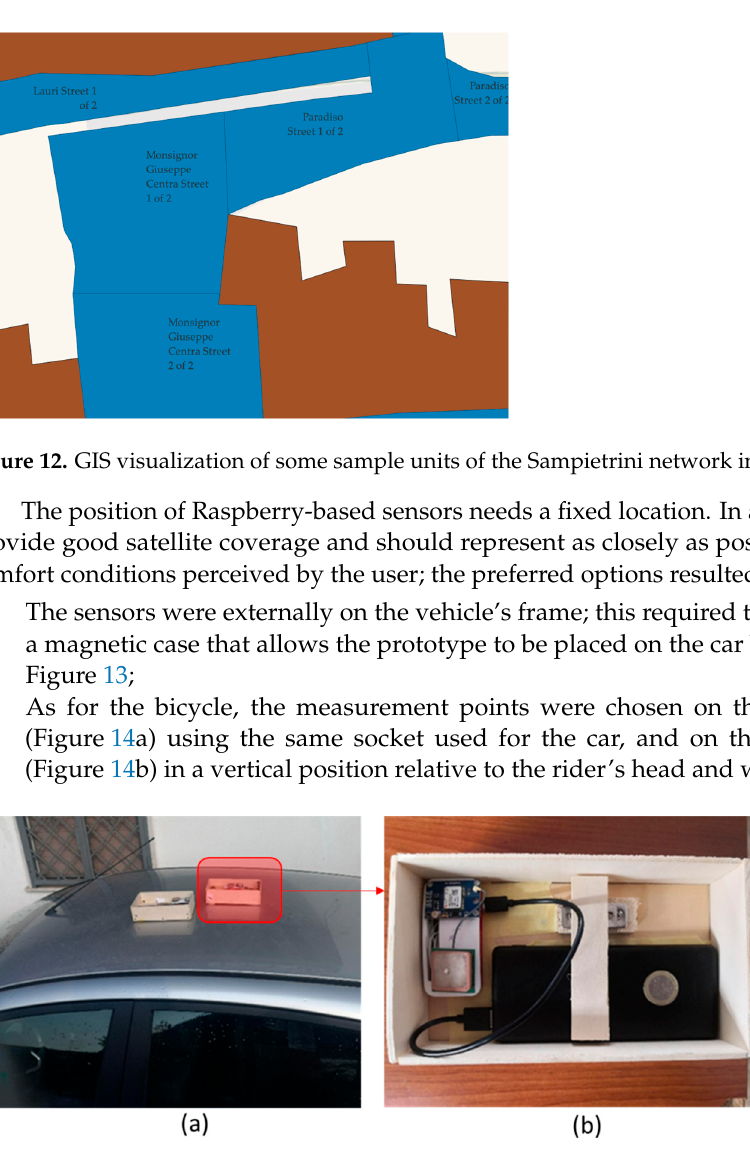
Figure 12. GIS visualization of some sample units of the Sampietrini network in Velletri.